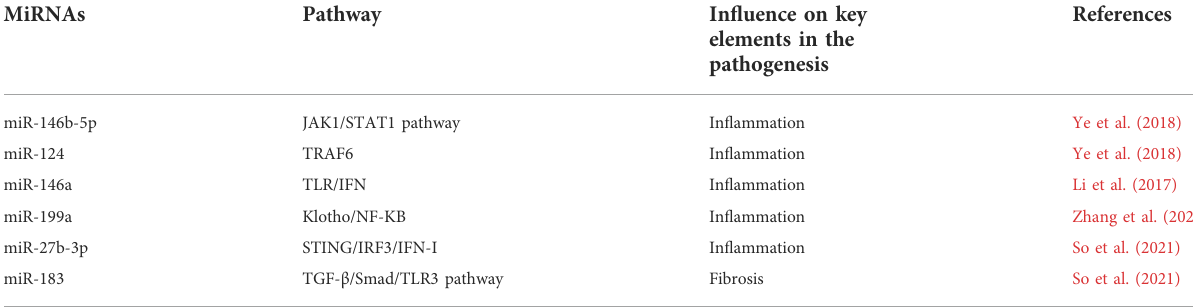
TABLE 1 miRNAs involved in the development and progression of lupus